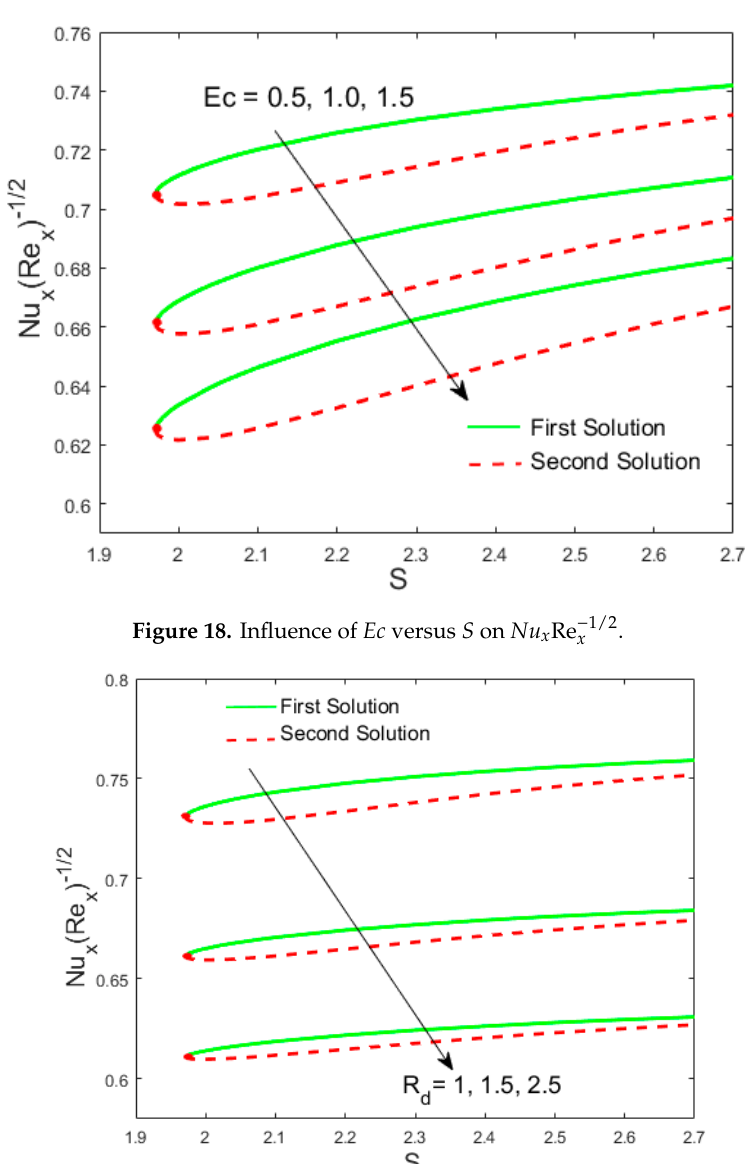
− 1/2 x R Nu − . versus S on 1/2 Re d x x